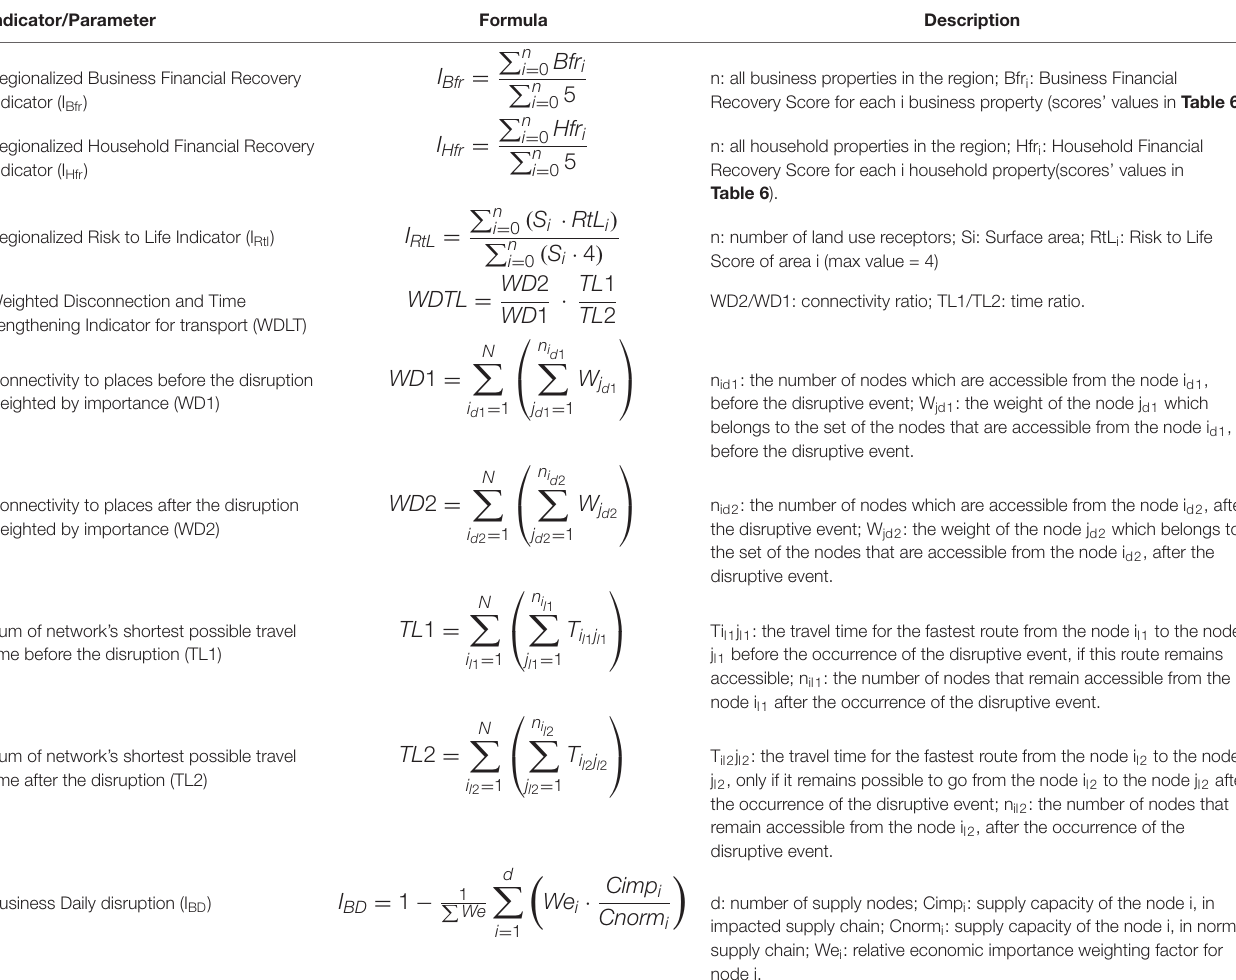
TABLE 7 | Descriptions and formulas of the main indicators and parameters calculated by the INDRA model for business financial and household recovery, risk to life and transport and business disruption. Indicator/Parameter Formula